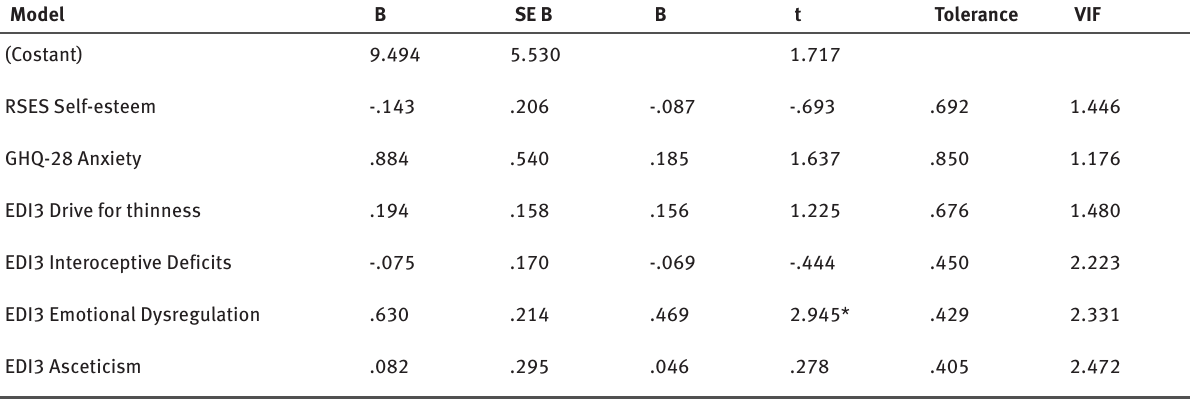
Table 4: Regression analysis predicting binge eating symptoms